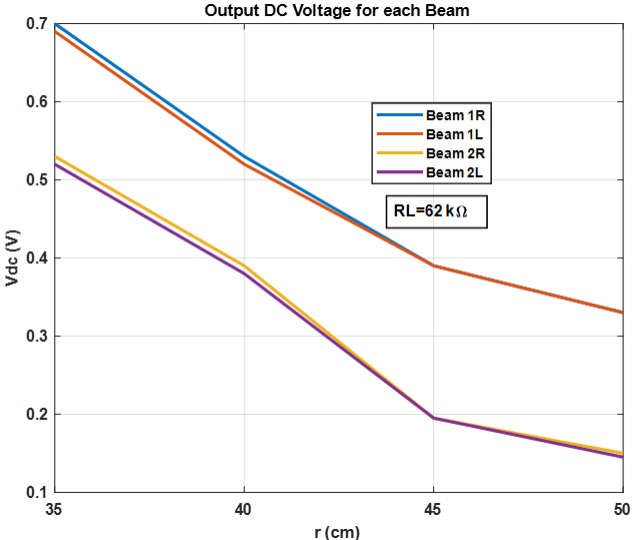
Figure 28. Measurement of maximum DC voltage for four output